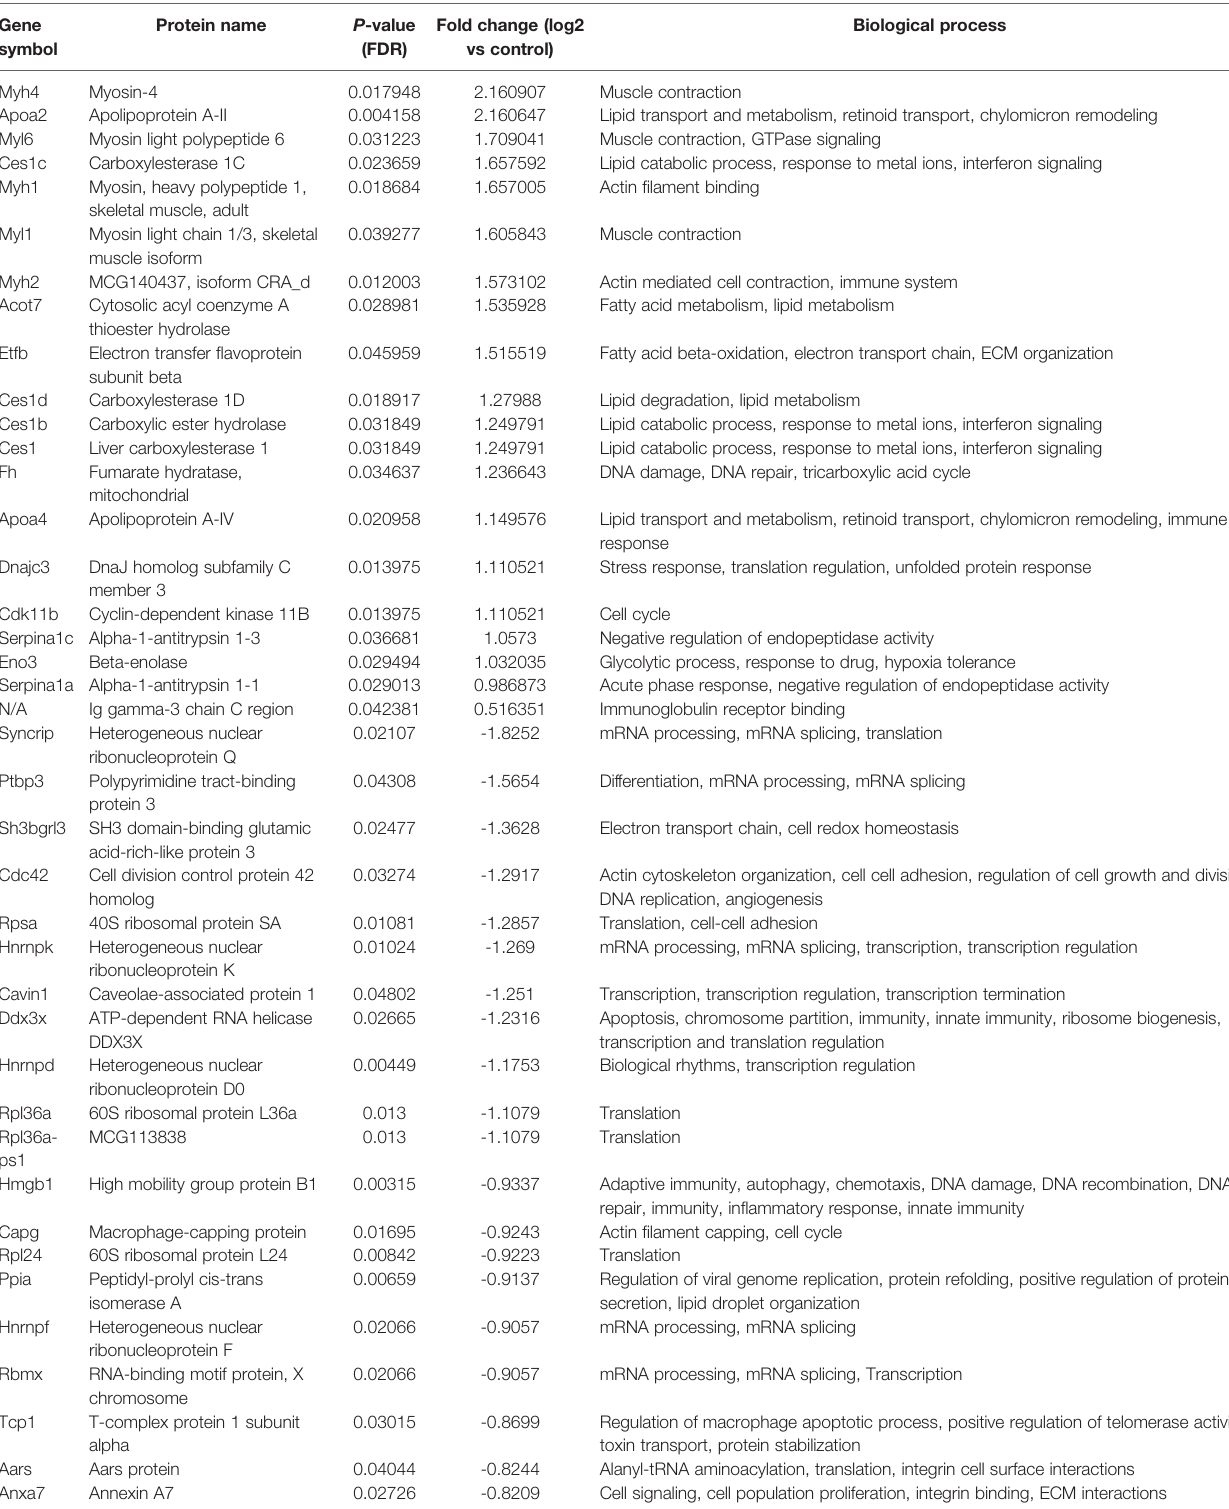
TABLE 4 | List of differentially regulated proteins in AG.1 and 5-FU treated group vs control group. Positive fold-change value denotes up-accumulation and negative fold change value denotes down-accumulation in comparison with